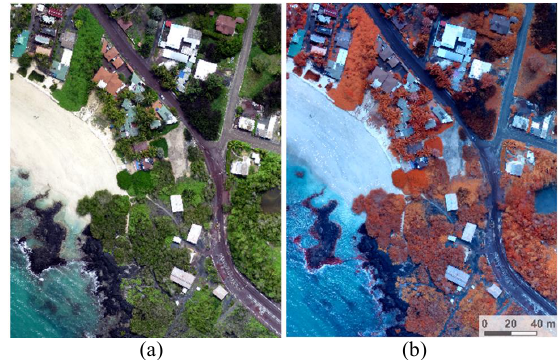
Figure 3. Region of interest. (a) RGB image and (b) NIR image